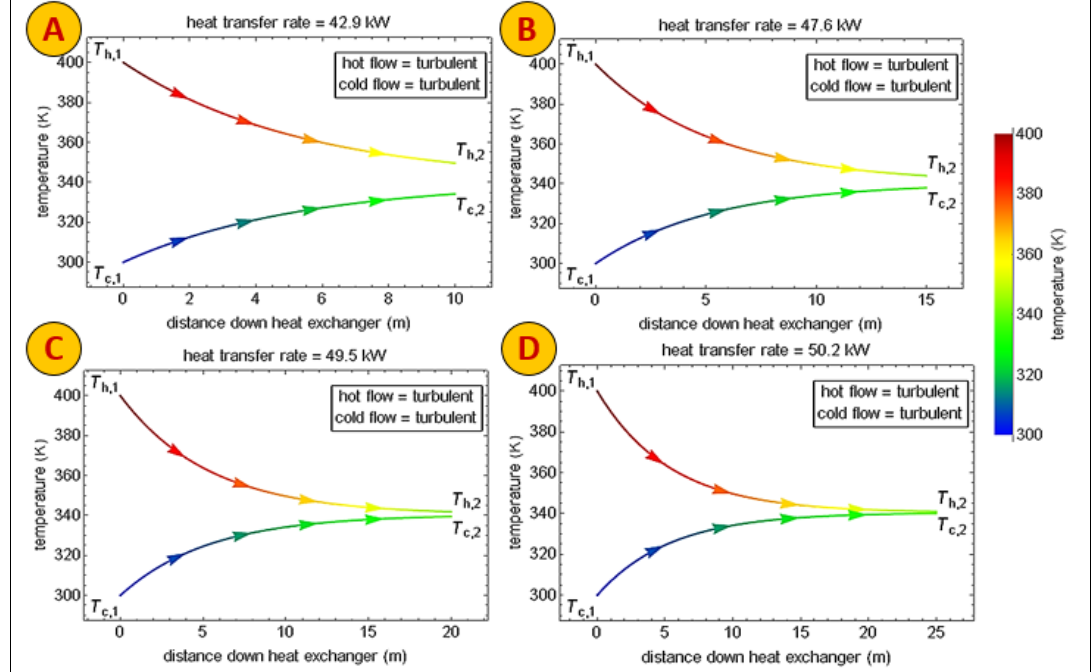
Figure 5. Parallel HE temperature distribution at length of (A), 10 m (B), 15 m (C), 20 m, and (D) 25